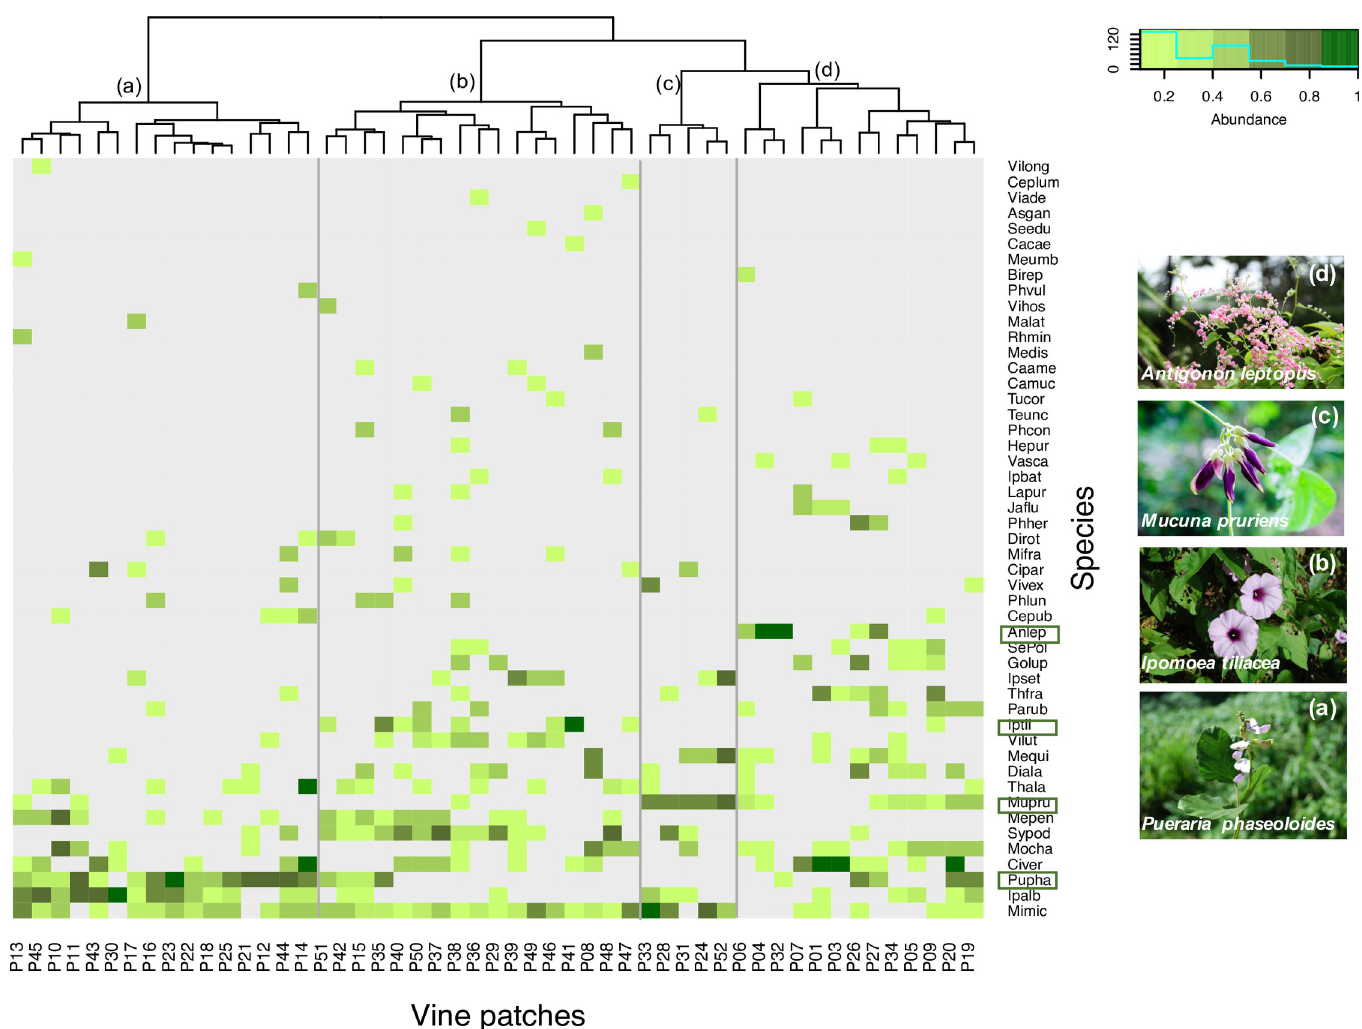
Fig 3. Heat map of vine patches and species abundances. The dendrogram on the top identifies four clusters generated by the hierarchical cluster analysis (a-d; based on Bray-Curtis dissimilarity index and Ward clustering methods). The photos on the right shows the main indicator vine species of the four clusters.